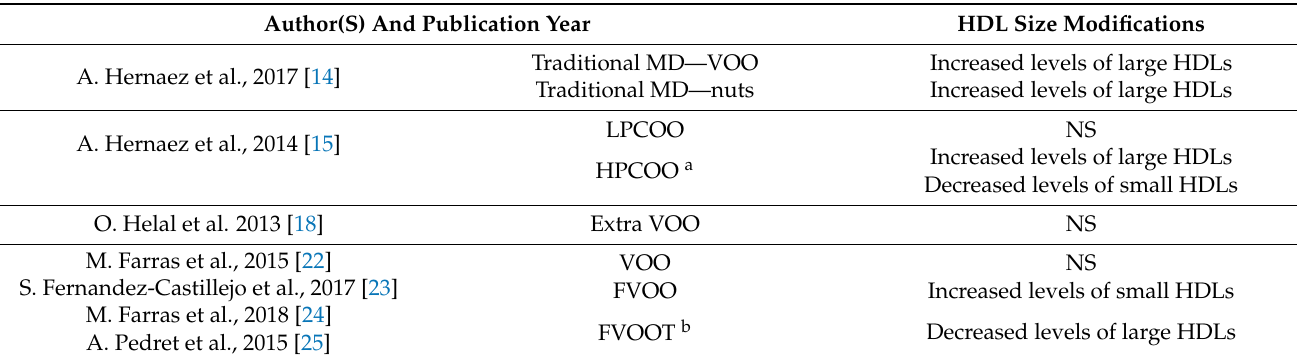
Table 6. High-density lipoprotein (HDL) size variation against